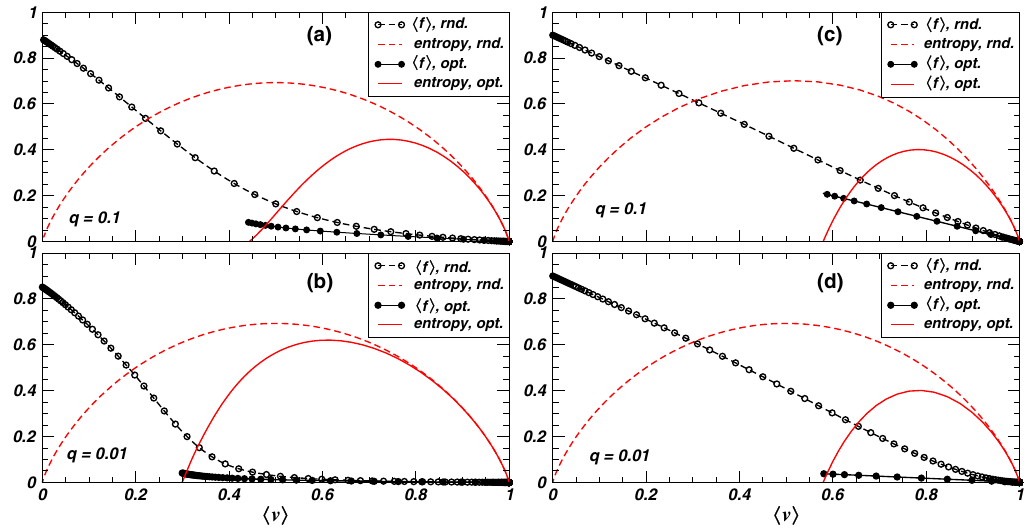
FIG. 6. Results for the analysis of the SIR and SIS models on random regular graphs of degree K ¼ 4 , with uniform self-infection probability q ¼ 0 . 1 . 0.01 and uniform transmission probability p ¼ 0 . 5 . For the SIR model (a,b), we plot the average density of nodes that got infected during the epidemic spreading h f i as a function of the average density h v i of immunized nodes, both in the random case (open circles) and under optimization (full circles). For the SIS model (c,d), we plot the average density h f i of infected nodes in the stationary state as a function of the average density h v i of immunized nodes, both in the random case (open circles) and under optimization (full